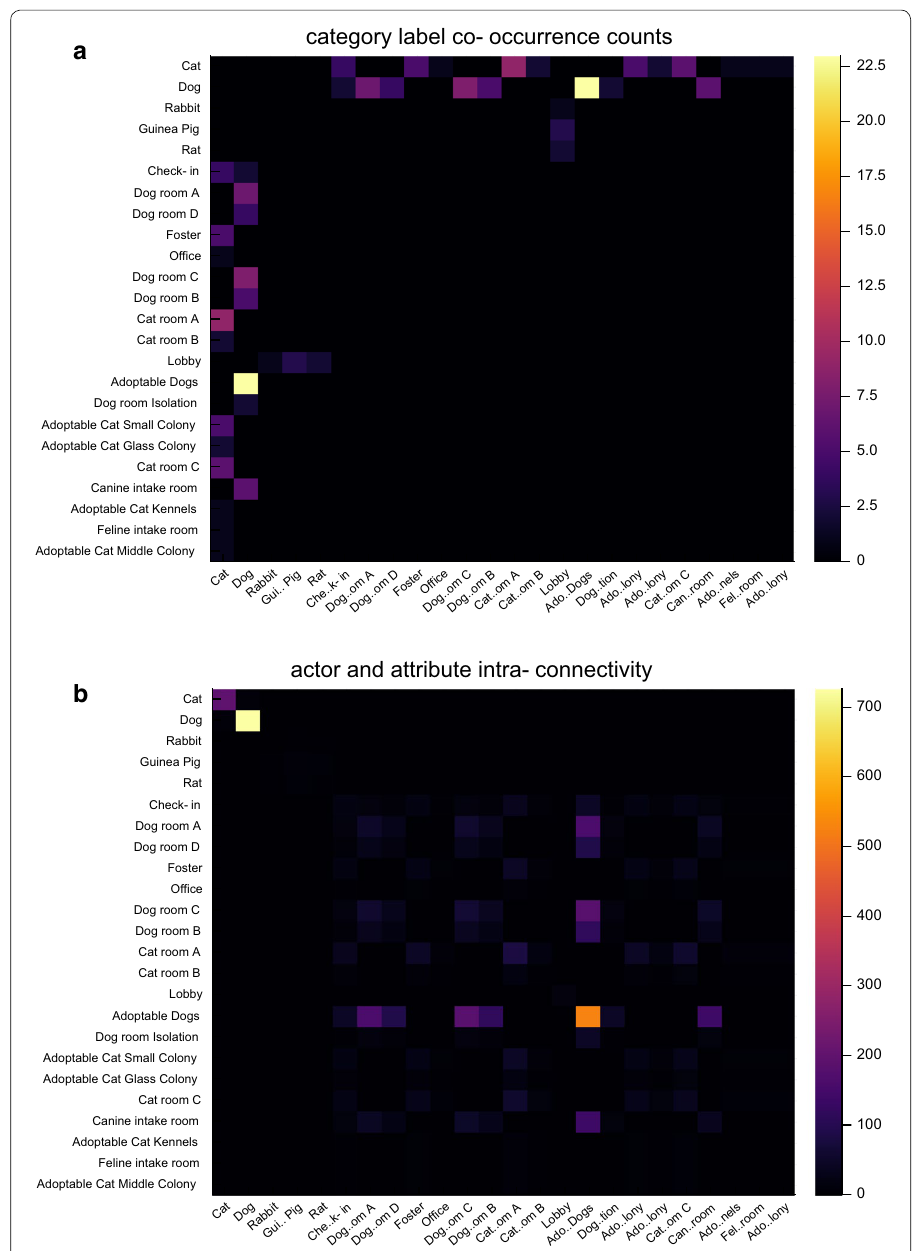
Fig. 4 This is the matrix view of the associations based upon a count of event co-occurrences (data from Bloomington Animal Shelter data.gov ). a Shows the discrete variable value event co-occurrences in the rows of the data (csv in this case) as an aggregate count between labels. b Shows the connectivity with labels belonging to the same variable (column) as a result from counting walks of length 2 (taking the square of the co-occurrence matrix). Both subfigures show the challenge of interpreting the data from such a visualization since sparsity, many label numbers, and large value discrepancies create challenges to the viewer (x-axis label names are